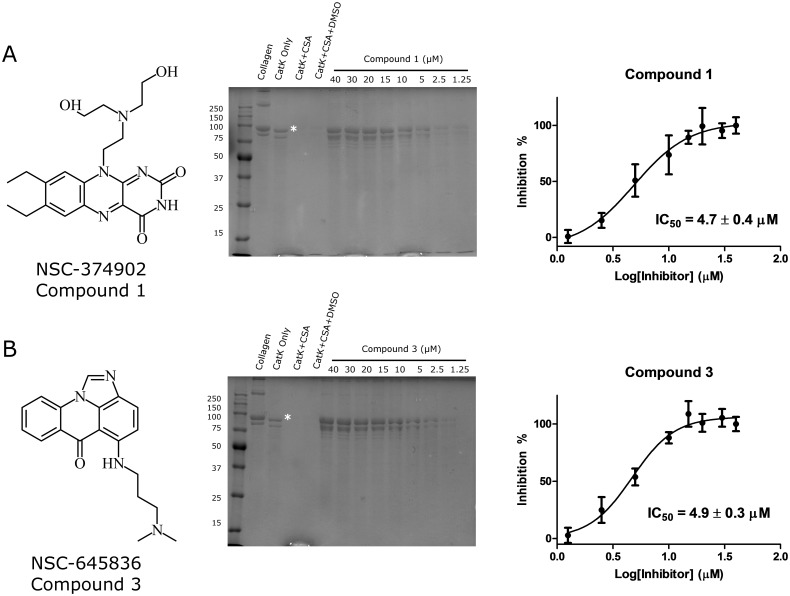
Collagenase inhibitory activity of compounds 1 and 3.The two most potent compounds, 1 (A) and 3 (B), identified through molecular docking are shown with their respective structures. Collagenase inhibitory activities with representative collagenase degradation gels are depicted with the corresponding IC50 curves determined from three separate experiments (n = 3). The IC50 values for the inhibition of collagenase activity of CatK were 4.7 ± 0.4 μM and 4.9 ± 0.3 μM for compounds 1 and 3, respectively. * represents the α1 type I collagen peptide used to quantify the collagenase activity of CatK.